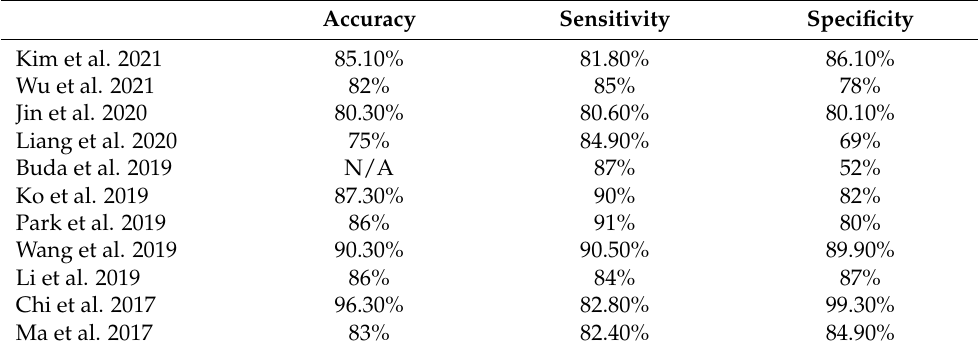
Table 6. Summarizing the accuracy of deep learning results from recently published studies [105–114].